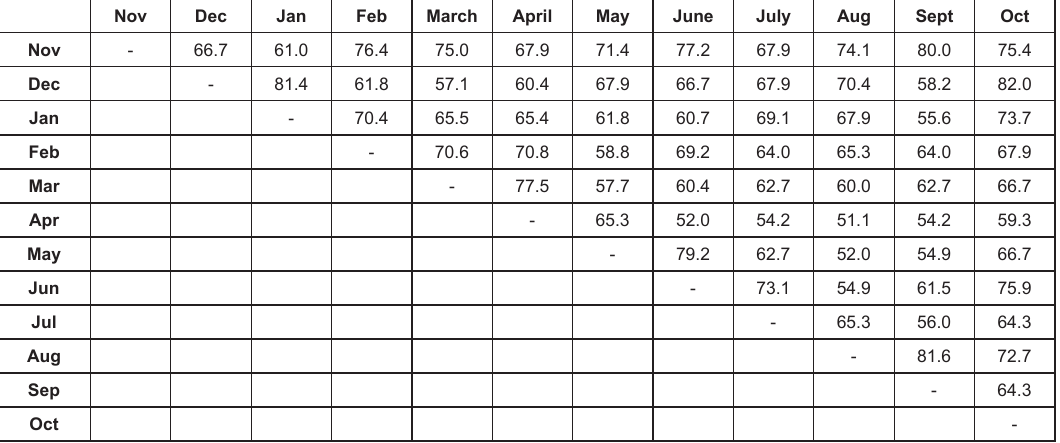
Table 5. Percentage similarities between Zooplankton communities